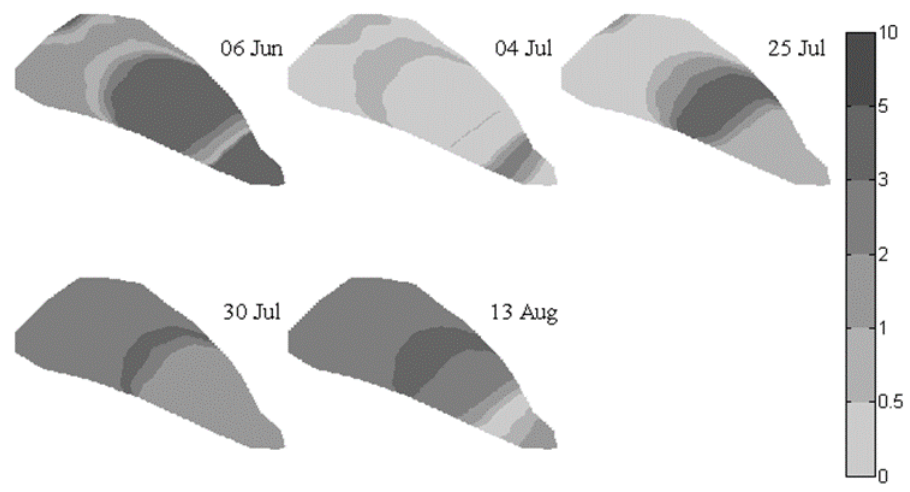
Figure 6. Spatiotemporal variations of BC concentrations (ppb) in surface snow over the QT No. 1 Glacier from 6 June to 13 August in 2015. Not all data are shown due to a limited number of